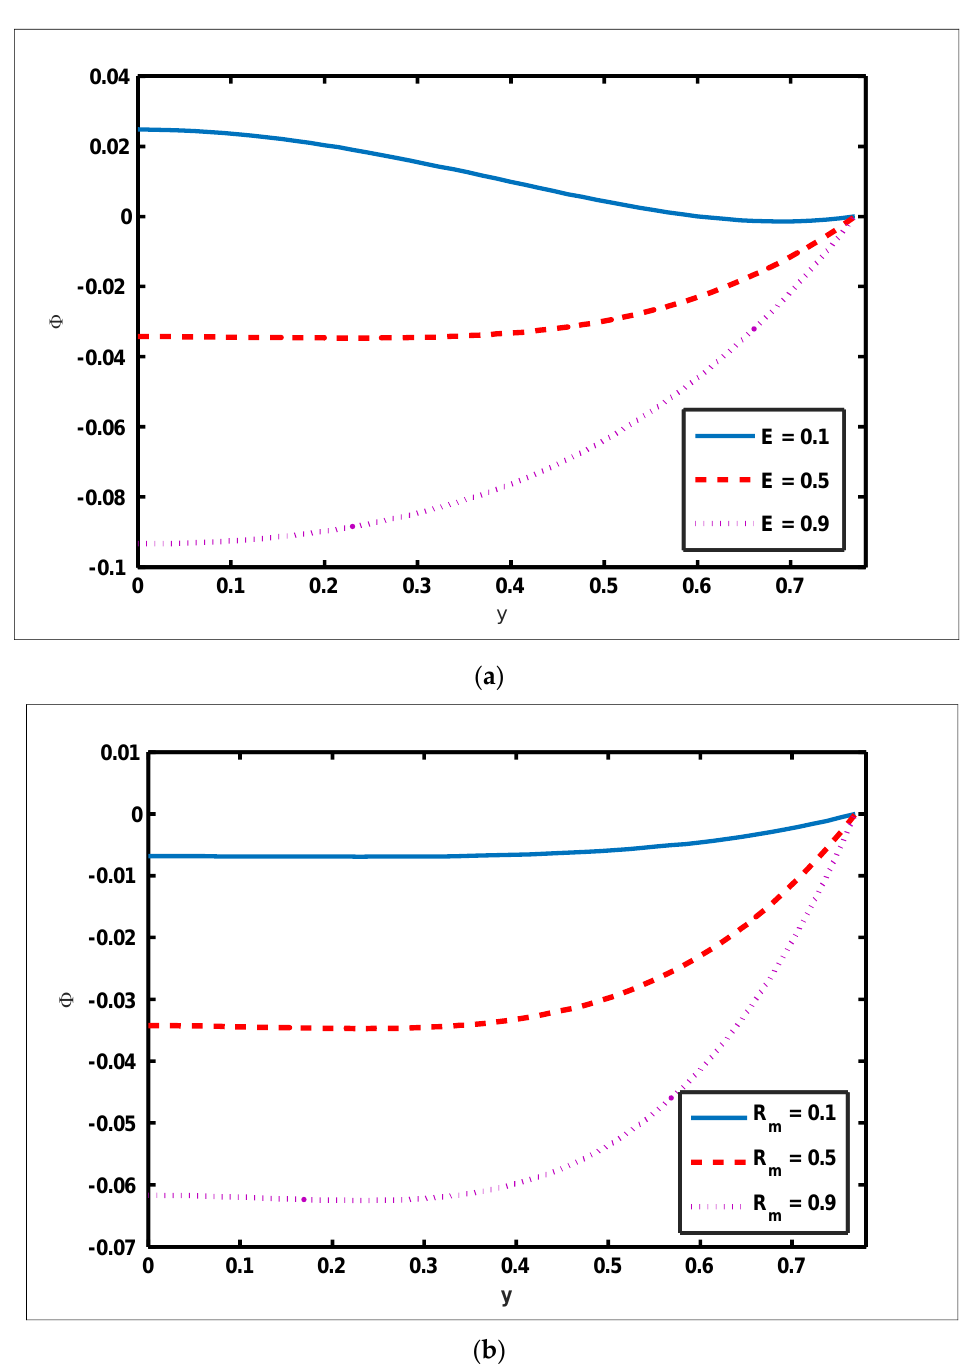
Figure 7. Magnetic force function for induced electric field and magnetic Reynolds number. Values of other physical parameters are ( a ) N t = 0.3, N TC = 1.2, N b = 0.4, b = 0.7, a = 0.3, N CT = 0.9, R m = 0.5, G rc = 1.4, x = 0.6, G rt = 0.5, G rF = 0.8, α = 0.8, Q = 3, (cid:101) η = 1, (cid:101) µ = 1. ( b ) N t = 0.3, N TC = 1.2, N b = 0.4, b = 0.7, a = 0.3, N CT = 0.9, E = 0.5, G rc = 1.4, x = 0.6, G rt = 0.5, G rF = 0.8, α = 0.8, Q = 3, (cid:101) η = 1, (cid:101) µ = 1. Trapping is an infrequent occurrence in peristaltic progressed flows. It is stimulated by the internal movement of a fluid mass enclosed by peristaltic wave streamlines. With peristaltic movement at high flow rates and large occlusions, streamlines capture the fluid mass bolus and carry it forward. The aspects of streamlines are depicted in Figures 8–10 for various values of Wi , G rc , and N t . It should be noticed in Figures 8 and 9 that